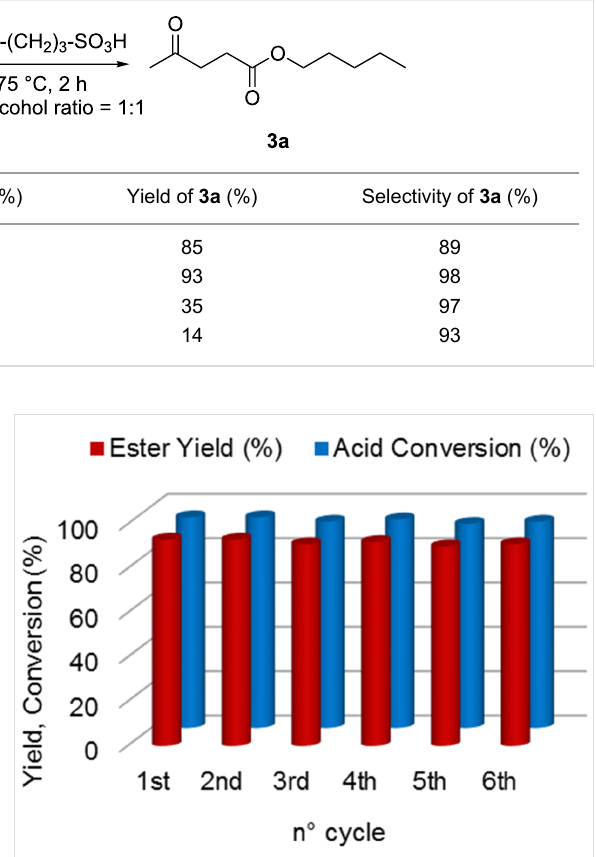
Table 4: Effect of the amount of catalyst.